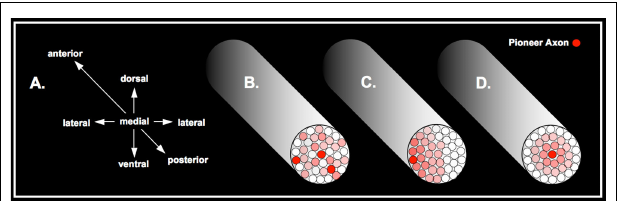
FIGURE 6 | Here a schematic cross-section of the arcuate fasciculus is delineated. On the left (A) the orientation of the fasciculus are defi ned by three axes anterior–posterior, dorsal–ventral and lateral–medial. The second to the left scheme (B) represents a chaotic distribution of axonal fi bres, with several possible arbitrary positions of the pioneer axon, whereas the increased red colour typifi es older axonal pathways. The second to the right scheme (C) stands for a possible alternative order driven by a laterally oriented axonal architecture. At the right scheme (D) , the proposed architecture due to the maturation of the fasciculus is outlined as suggested by the Pioneer Axon Thesis – thus, the pioneer axon is located